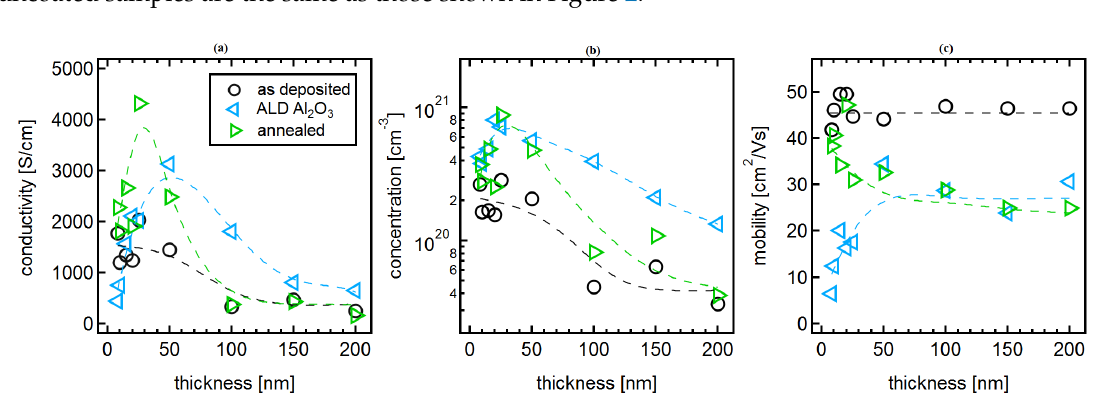
Figure 8. Hall effect measurements as a function of film thickness of ITO films deposited at room temperature (black circles), ITO films deposited at room temperature after Al 2 O 3 deposition, and ITO films deposited at room temperature after annealing in the ALD chamber (ALD-anneal) in vacuum at 200 ◦ C. Conductivity ( a ), carrier concentration ( b ) and carrier mobility ( c ). The data of the as-deposited films are the same as those in Figure 2. Dashed lines are a guide for the